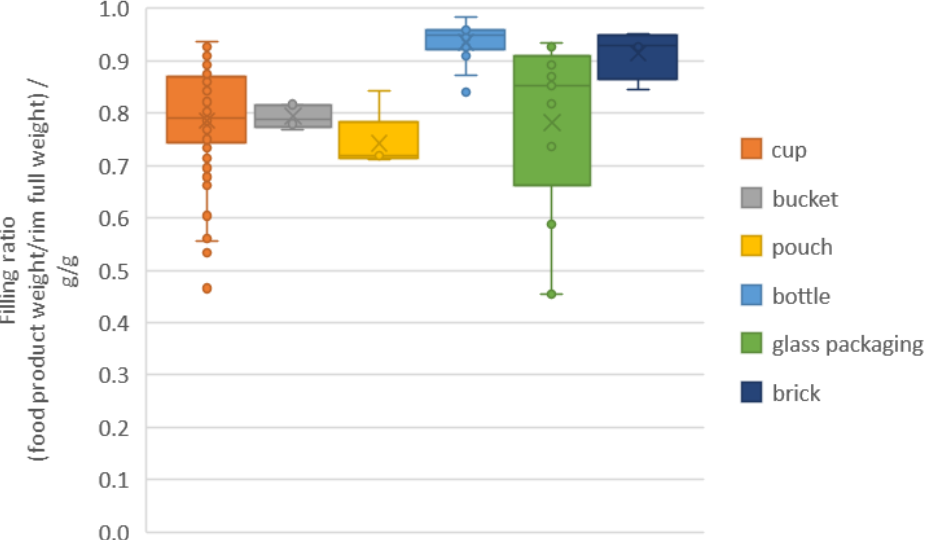
Table 1. Filling weight distribution of different packaging means; number in field: amount of pack- agings .